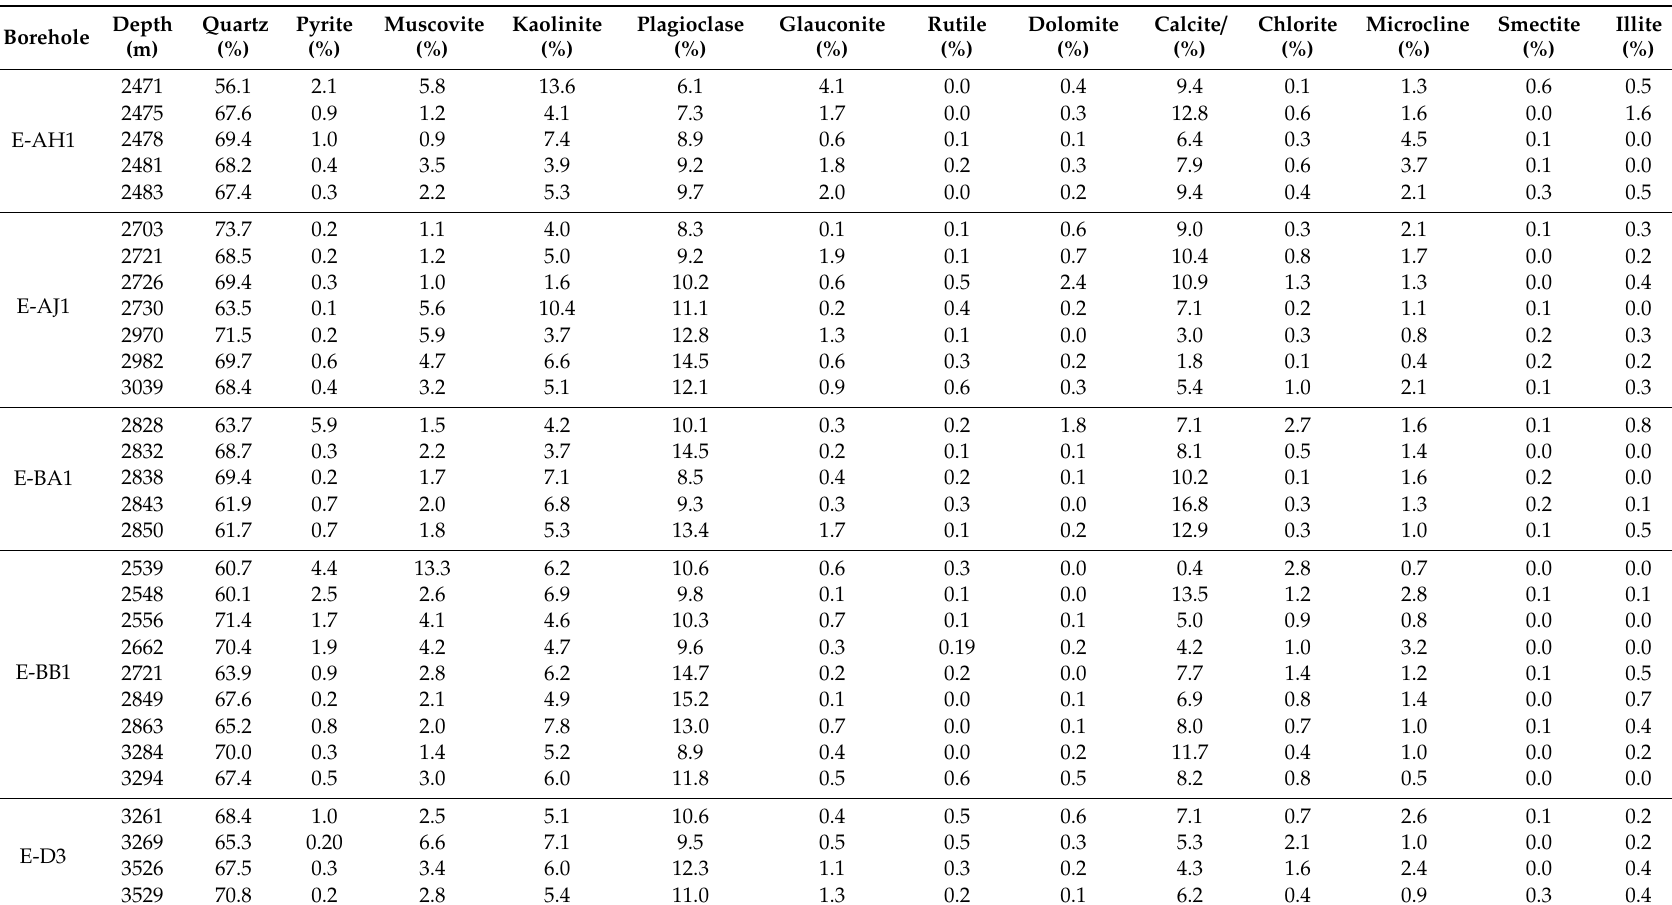
Table 6. Mineralogical composition of the studied sandstone samples from